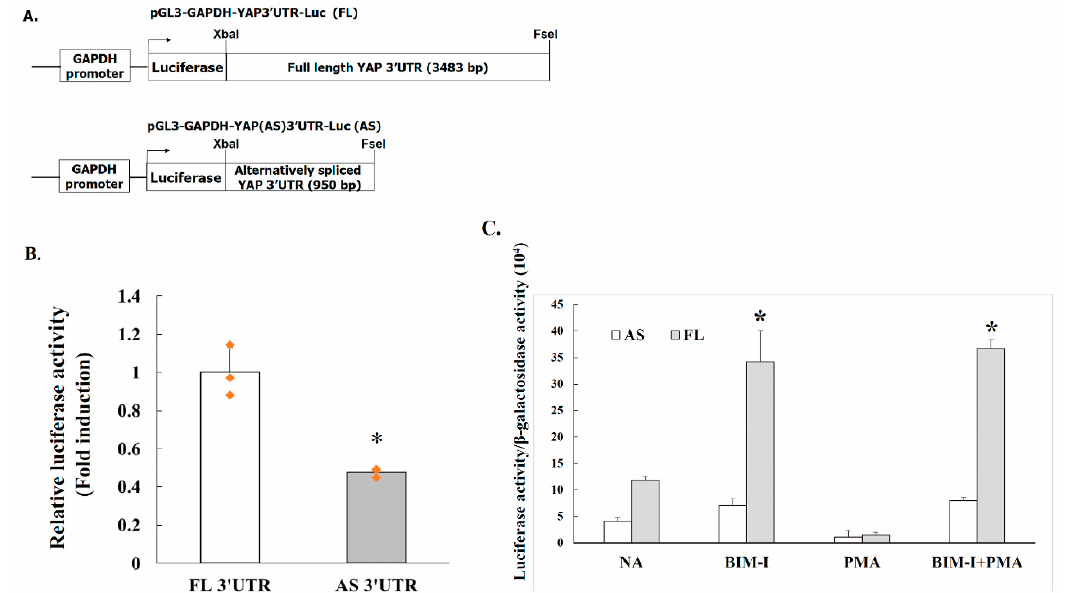
Figure 3. Increased PKC activity decreases YAP 3 (cid:48) UTR mRNA stability ( A ). Schematic presentation of constitutive luciferase reporter constructs (not drawn to scale). The 3 (cid:48) UTR full length and alternatively spliced 3 (cid:48) UTR of the YAP were cloned into the XbaI and FseI sites downstream to the firefly luciferase gene in the sense orientation. Transcription (bent arrow) was driven by the GAPDH promoter upstream to the luciferase reporter gene. ( B ). Luciferase construct containing YAP full length (FL) and alternatively spliced (AS) 3 (cid:48) UTR were transfected into PC-3 cells. The cells were also cotransfected with pSV- β -galactosidase vector, and the β -galactosidase activity was used to normalize the luciferase activity ( n = 3). Asterisks indicate a significant difference compared to the YAP full length 3 (cid:48) UTR. * denotes p < 0.05 ( t -test). ( C ). The PC-3 cells were transfected with pGL3-GAPDH-YAP-3 (cid:48) UTR-Luc or pGL3-GAPDH-YAP(AS)-3 (cid:48) UTR-Luc. Luciferase activity was assayed after the treatment of the cells with 2.5 µ M BIM-I or 50 nM PMA for 16 h ( n = 3). “BIM-I + PMA” represent that the cells were preincubated with BIM-I for 30 min before treatment with PMA. Asterisks indicate a significant difference between the alternatively spliced 3 (cid:48) UTR and the YAP full length 3 (cid:48) UTR. * denotes p < 0.05 ( t -test). NA: not